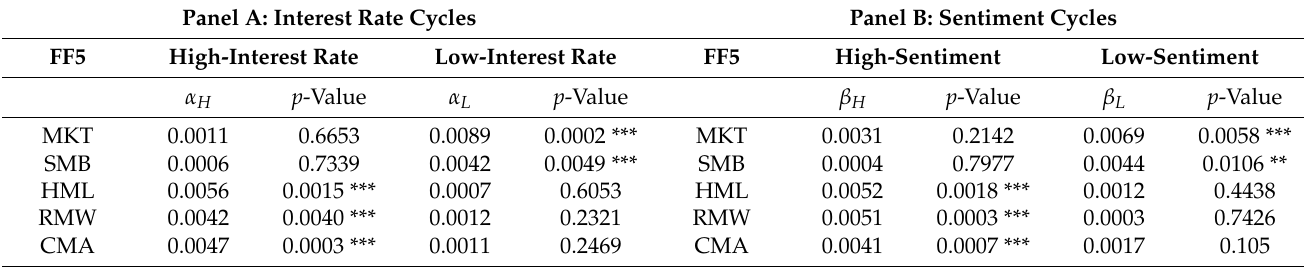
Table 3. Interest rate cycles and sentiment cycles on five-factor returns. Panel A presents the signifi- cance of five-factor returns in interest rate cycles for Equation (4); Panel B presents the significance of five-factor returns in sentiment cycles for Equation (5). The median of long-term real interest rate is 2.42%, greater than (less than) the median defined as a high-interest rate (low-interest rate) cycle; the median of market sentiment is 0.03, greater than (less than) the median defined as a high-sentiment (low-sentiment) cycle. All t-statistics are based on the Heteroskedasticity-Autocorrelation-Consistent standard errors. **, and *** denote significance at the 5%, and 1% levels, respectively. Panel A: Interest Rate Cycles Panel B: Sentiment